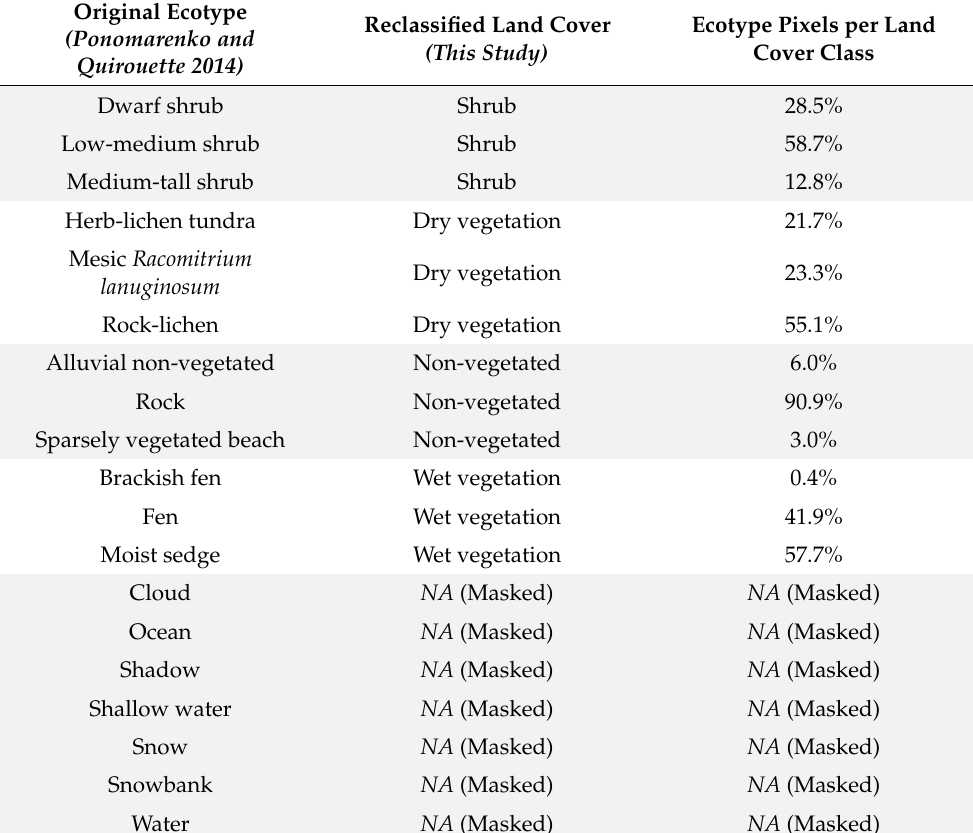
Table 1. Reclassification and percent composition of the original 19 ecotypes in four representative land cover